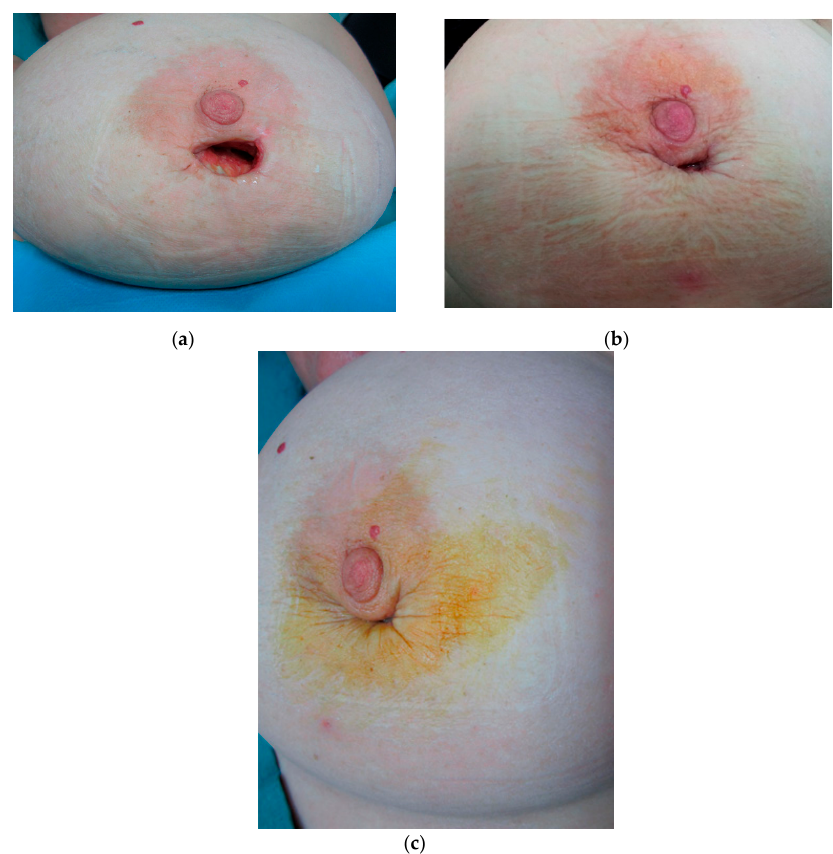
Figure 6. Patient undergoing surgical excision for a benign breast lesion who required two PRP treatments for the wound to heal. ( a ) pretreatment, ( b ) three weeks, ( c ) wound closure.